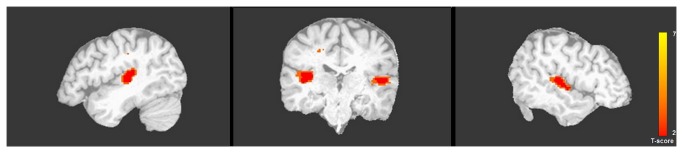
A representative subject illustrating activation in auditory cortex in the localizer session (p<0.001).